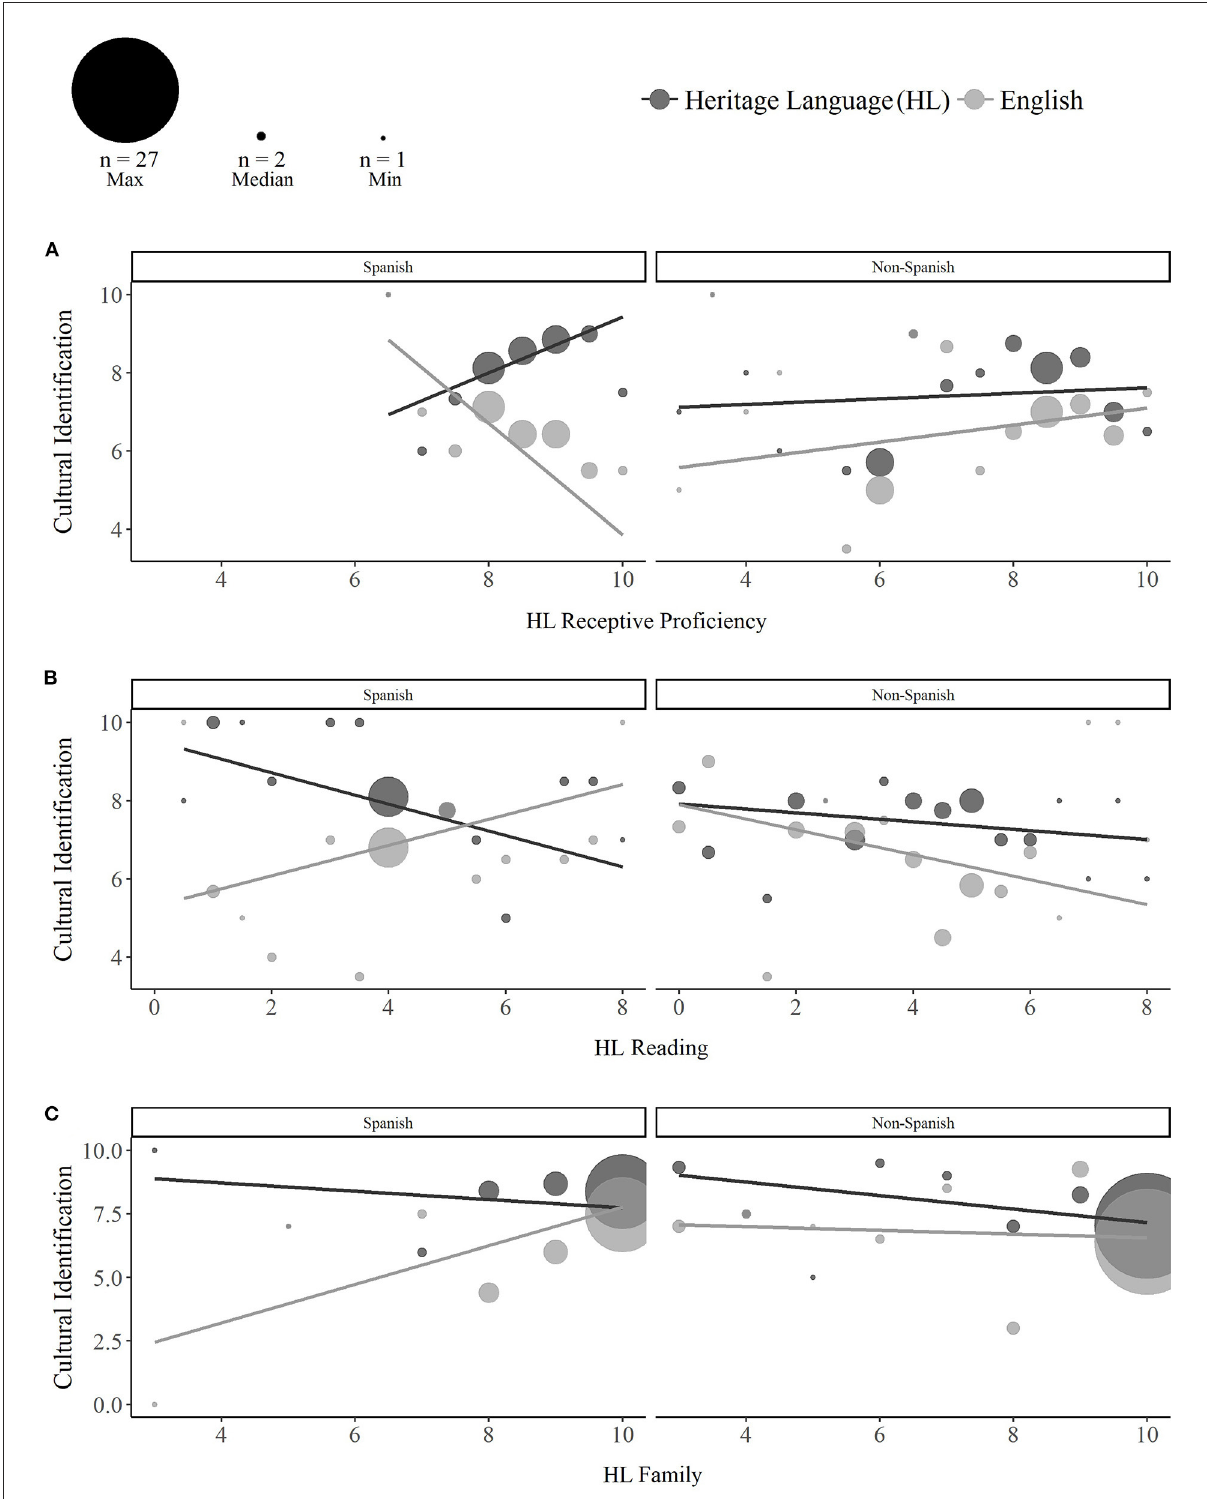
FIGURE5 Effects of heritage language (HL) experience on cultural identification with the HL (dark gray) and English (light gray). Among Spanish bilinguals, cultural identification with English increased with lower HL receptive proficiency (A) , as well as greater HL acquisition and exposure through reading (B) and family (C) . Dot sizes reflect the number of participants contributing to each aggregated value (max = 27, median = 2, min =